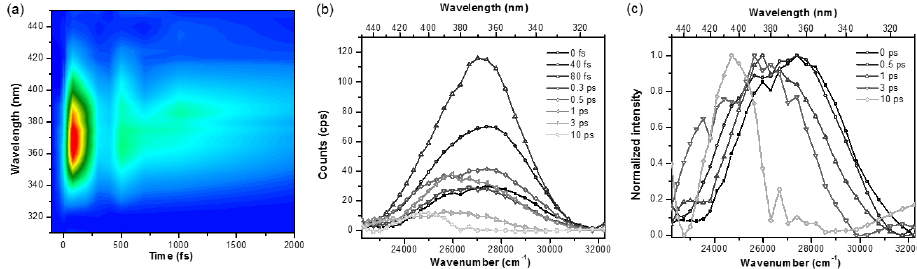
Fig. 1. Time-resolved fluorescence spectra Au(CN) 2− 0.3 M aqueous solution represented by (a) contour plot, (b) raw data, and (c) normalized intensity plot for better comparison.